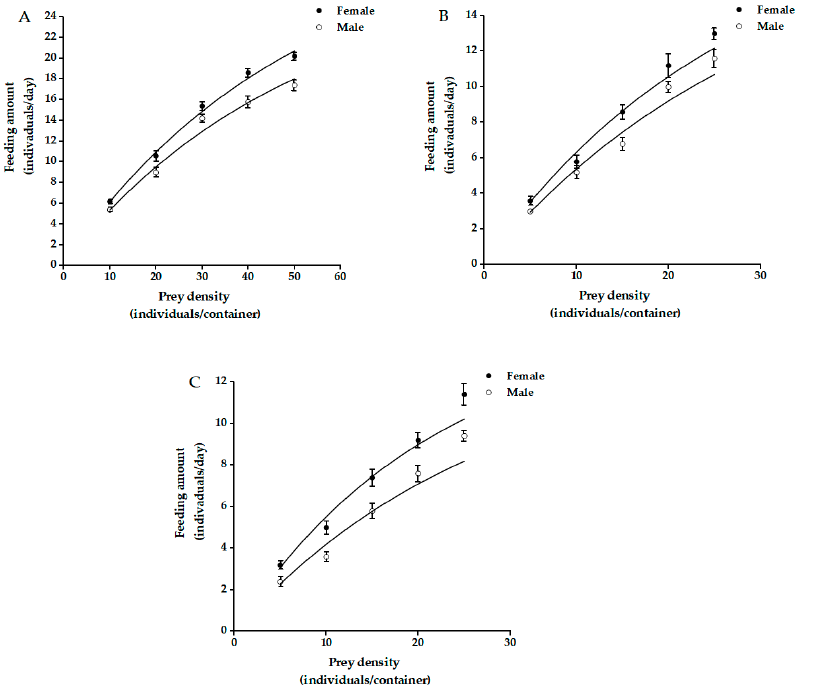
Figure 1. Fitting curve of predation function responses of C. elysii adults to juvenile ( A ), immatures ( B ), and adults ( C ) of A. agrestis . Table 1. Functional responses of C. elysii adults to distinct sizes of A. agrestis .